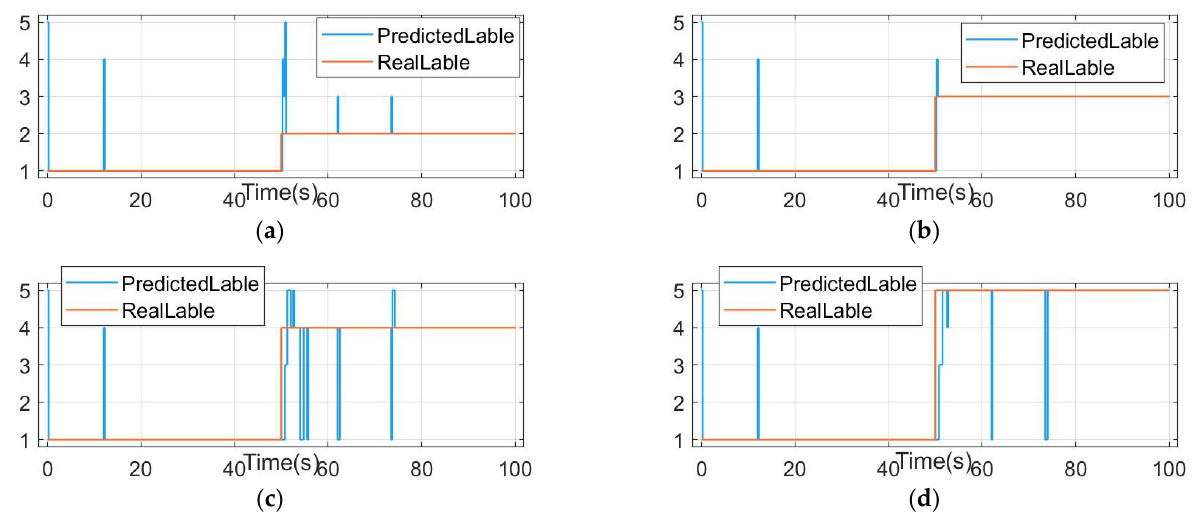
Figure 8. Fault mode classification of thruster in fault states: ( a ) fault mode classification of a thruster with an entanglement fault; ( b ) fault mode classification of a thruster with a jamming fault; ( c ) the fault mode classification of a thruster with a breaking fault; ( d ) fault mode classification of a thruster with a falling-off fault.